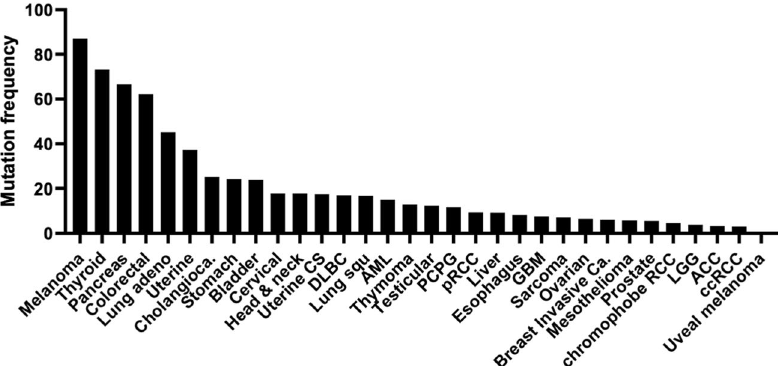
Fig. 1 Over 30 human cancer types characterized by the Cancer Genome Atlas (TCGA, USA) harbor noticeable subsets of patients bearing somatic mutations of the MAPK pathway. Abbreviation: Melanoma Skin Cutaneous Melanoma, Thyroid Thyroid Carcinoma, Pancreas Pancreatic Adenocarcinoma, Colorectal Colorectal Adenocarcinoma, Lung adeno Lung Adenocarcinoma, Uterine Uterine Corpus Endometrial Carcinoma, Cholangiocarcinoma Cholangiocarcinoma, Stomach Stomach Adenocarcinoma, Bladder Bladder Urothelial Carcinoma, Cervical Cervical Squamous Cell Carcinoma & Endocervical Adenocarcinoma, Head & neck Head and Neck Squamous Cell Carcinoma, Uterine CS Uterine Carcinosarcoma, DLBC Lymphoid Neoplasm Diffuse Large B-cell Lymphoma, Lung squ Lung Squamous Cell Carcinoma, AML Acute Myeloid Leukemia, Thymoma Thymoma, Testicular Testicular Germ Cell Tumors, PCPG Pheochromocytoma and Paraganglioma, pRCC Kidney Renal Papillary Cell Carcinoma, Liver Liver Hepatocellular Carcinoma, Esophagus Esophageal Adenocarcinoma, GBM Glioblastoma Multiforme,